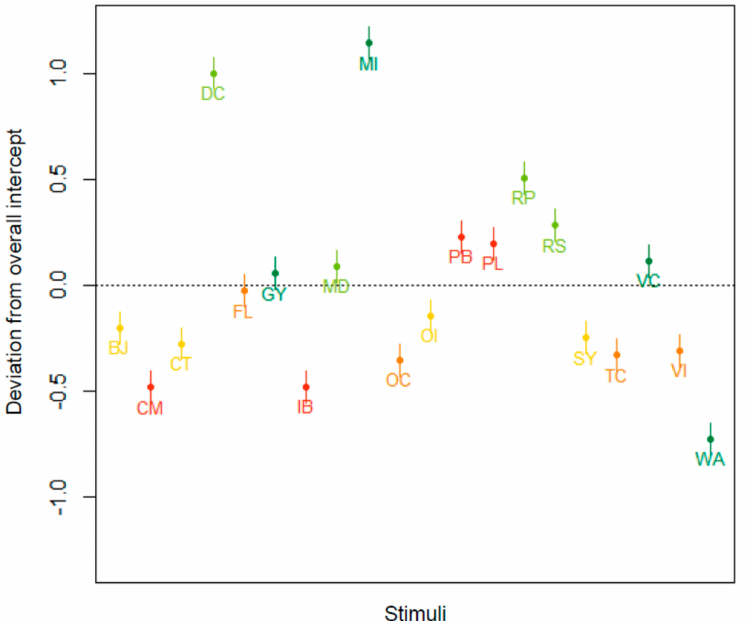
Figure 4. By-stimulus random intercepts for the 20 products used as stimuli in the experiment. WA = water; DC = diet coke; BJ = blood orange juice; FL = fresh lemonade; PL = processed lemonade; MI = mocha ice cream; RS = raspberry sorbet; OI = orange ice cream; VI = vanilla ice cream; IB = ice cream bars; VC = vegetable curry; MD = meat dish; CT = chicken tajine; TC = Thai curry; PB = prawns in garlic butter; GY = Greek yoghurt; RP = rice pudding; SY = strawberry yoghurt; OC = organic chocolate mousse; CM = chocolate